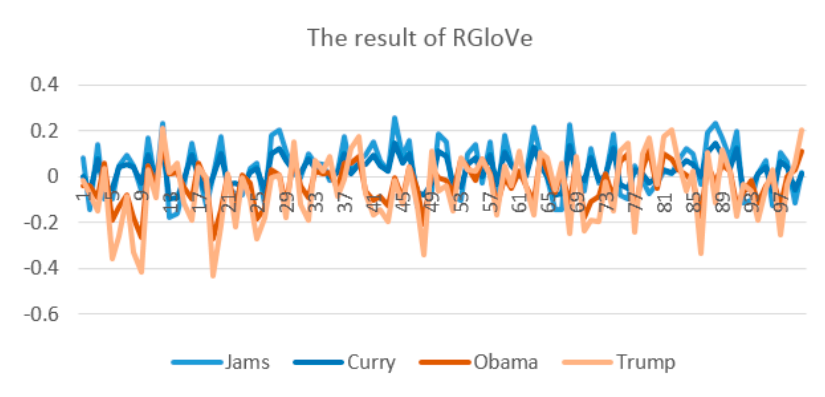
Figure 4. The result of GloVe.